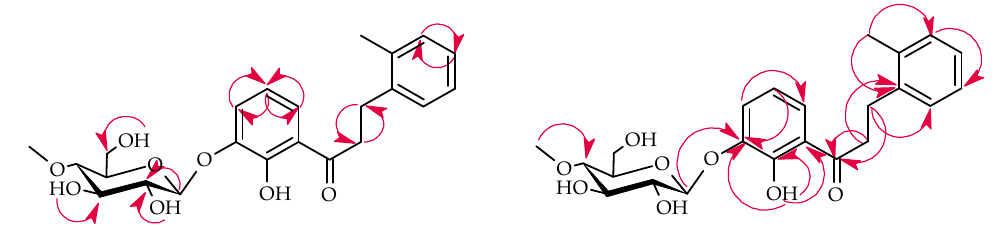
(Supplementary Materials: Figure S34, S52, S71, S89). Scheme 3. Key COSY (on the left) and HMBC (on the right) correlations for the structure elucidation of product ( 3a ).